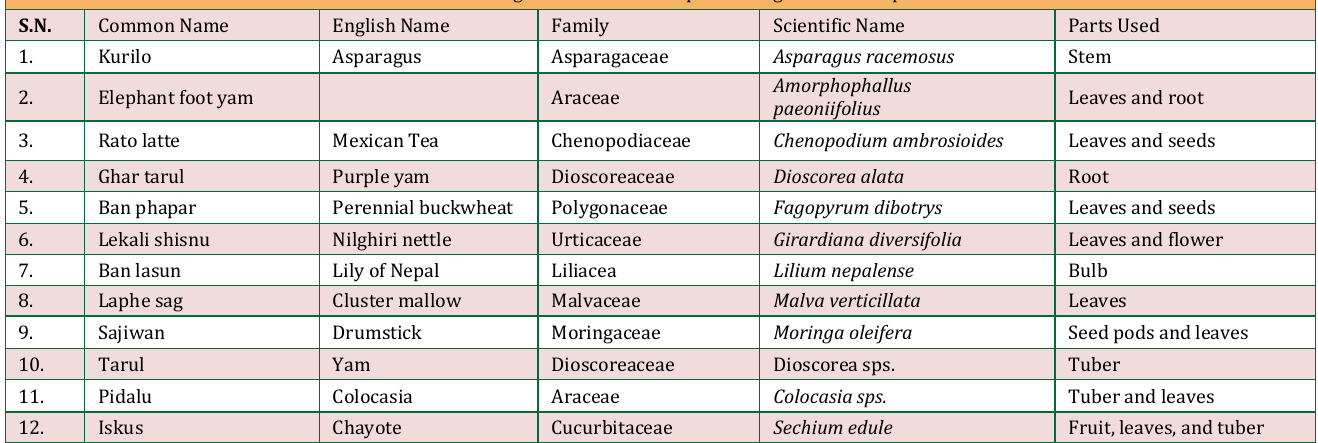
Table 3: Indigenous and underexploited Vegetables in